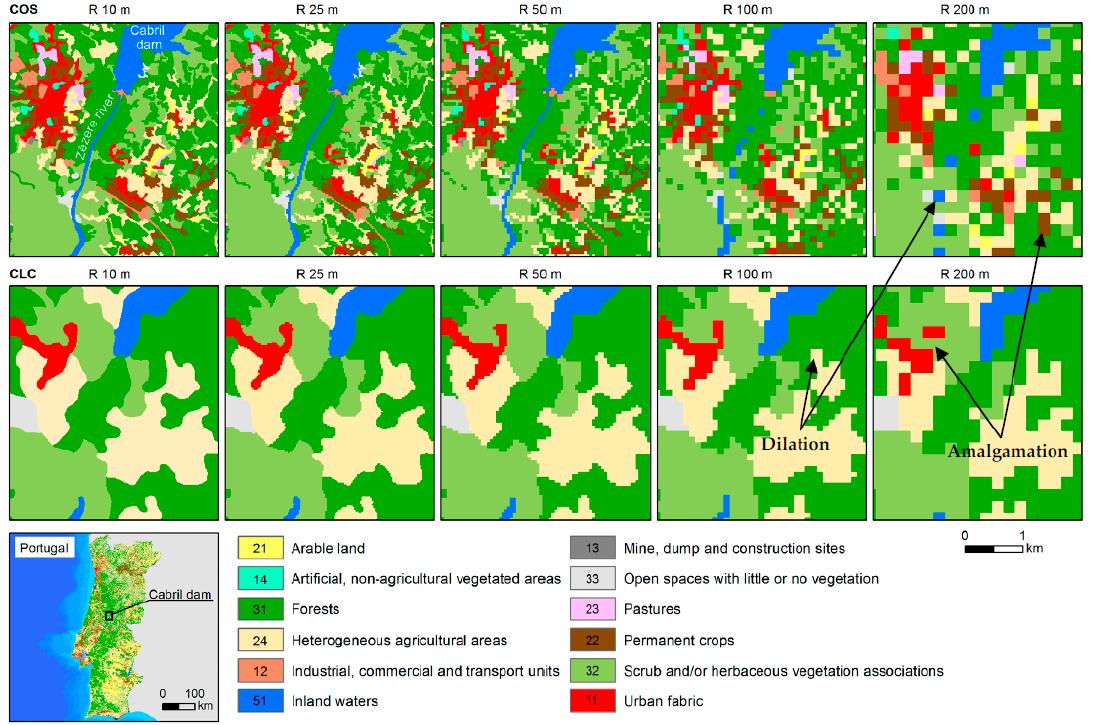
Figure 4. LUC extracts with different resolutions (COS 2010 and CLC 2012) in the central region of Portugal (downstream of Cabril Dam).